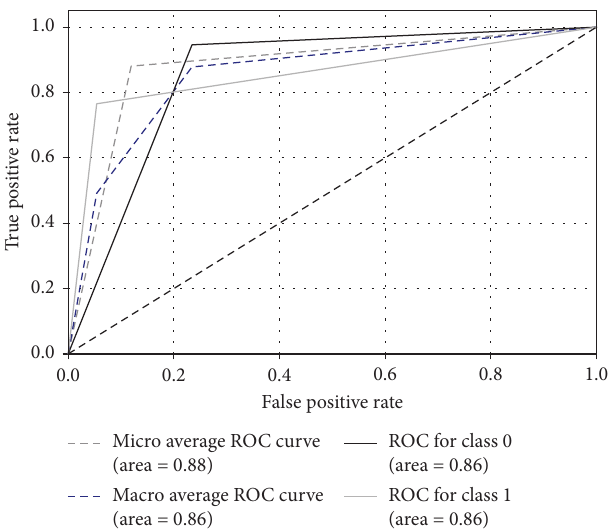
Figure 8: ROC curve for testing data using SVM model.